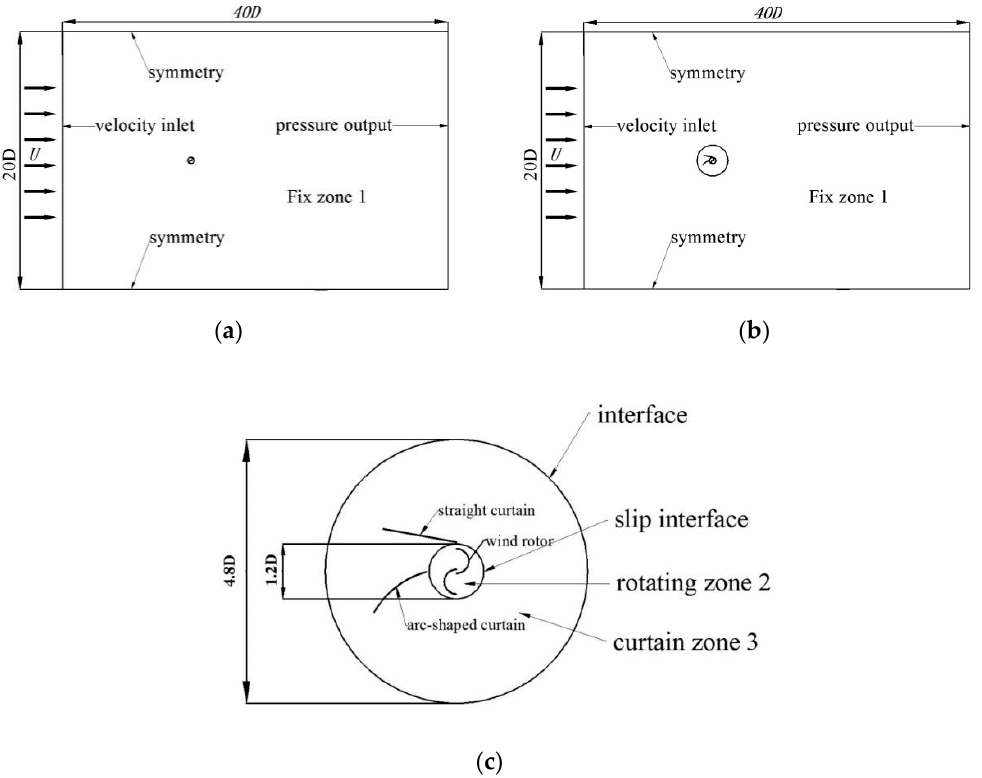
Figure 6. ( a ) Calculation domain without the curtain; ( b ) calculation domain with the curtain; ( c ) the calculation domain with the curtain.